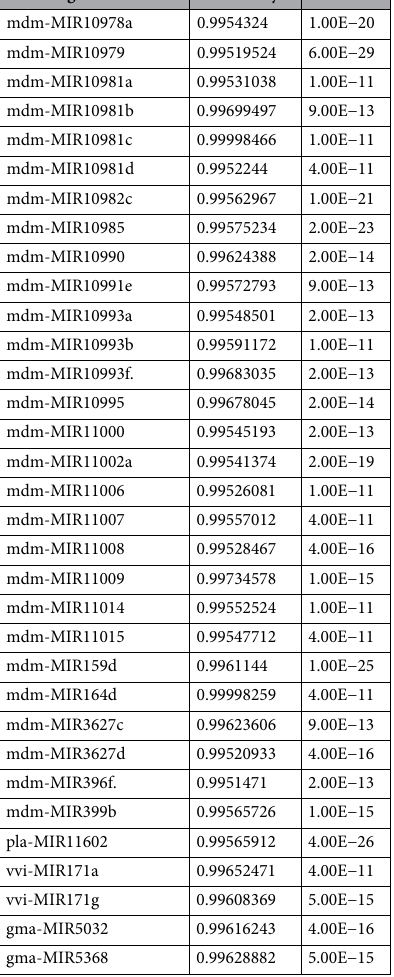
Table 2. Results of miRNA prediction with the combined approach of SVM classification and homology- based identification. a pre-miRNA records from miRBase. mdm: Malus domestica ; pla: Paeonia lactiflora ; vvi: Vitis vinifera ; gma: Glycine max. b Trained SVM classifier probability value. c E-value threshold applied for the BLAST